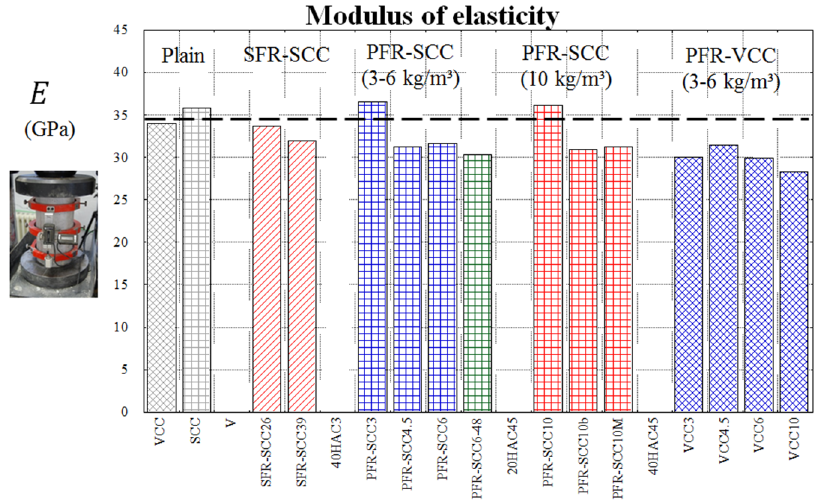
Figure 6. Modulus of